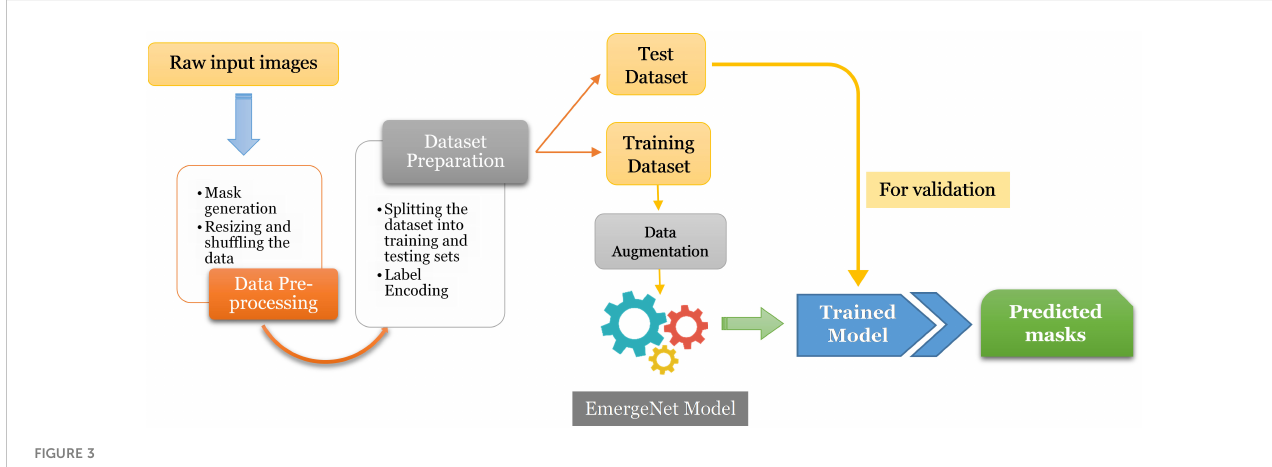
FIGURE 3 Flowchart of the proposed